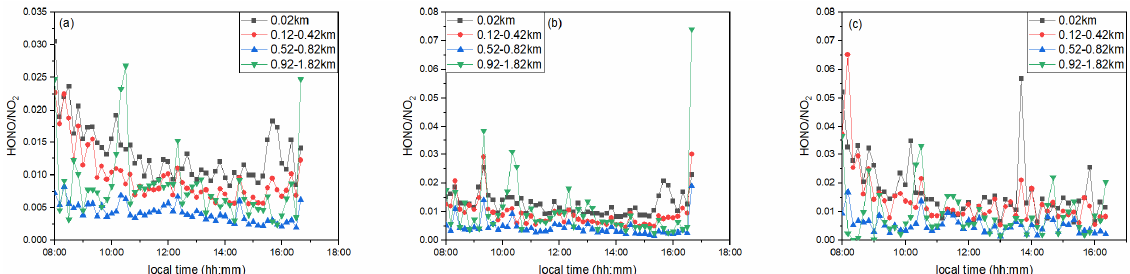
Figure 10. Diurnal variations of HONO/NO 2 at different altitudes. ( a ) is average of all the valid days; ( b ) is clear days; ( c ) is haze days. Different colored lines represent different altitudes: 0.02 km black; 0.12–0.42 km red; 0.52–0.82 km blue; 0.92–1.82 km